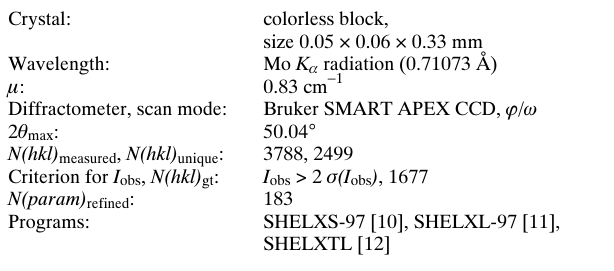
Table 1. Data collection and handling.